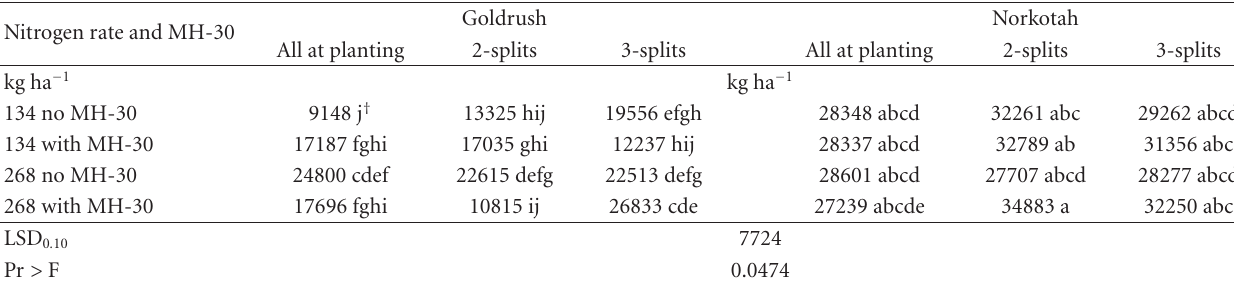
Table 5: Nitrogen rate × N application timing × variety × MH-30 interaction in 2010 for marketable yield for Russet potatoes grown on sandy loam soils in the